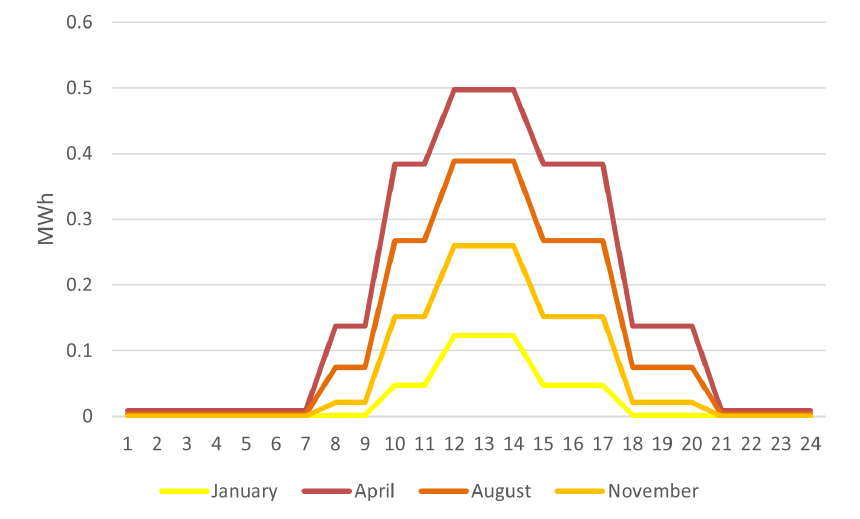
Figure 2. Assumed generation profiles of a day in the different times of the year, source: EEMM data. Considering all above, the results of the own LCOE calculation are presented on Figure 3.